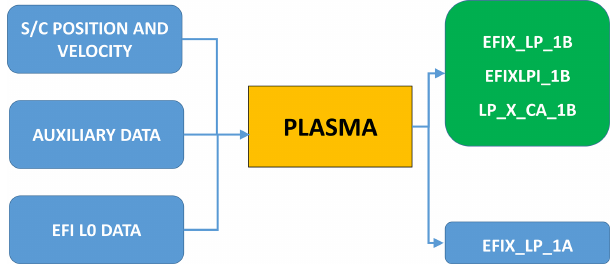
Figure 2. Schema of the L1B PLASMA operational processor. The blue boxes on the left side represent the input files, the central yellow box represents the PLASMA processor, and the right-side boxes represent the processor outputs. In particular, the green box contains the EFI-LP L1B data